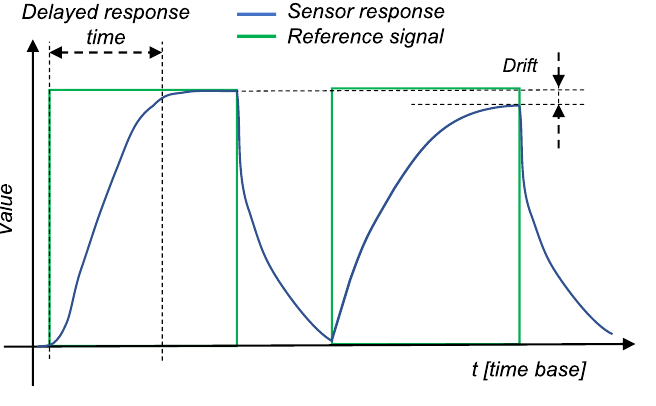
Figure 1. Drift and delay or sensor